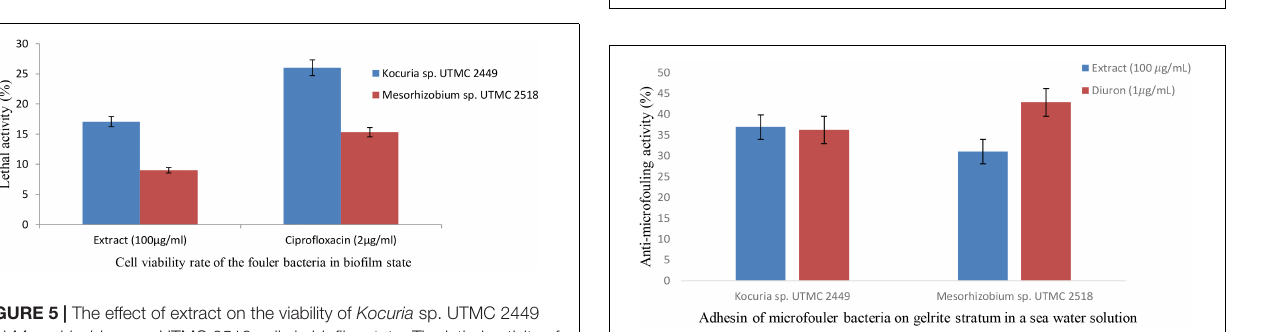
FIGURE 6 | Hemolytic activity of Glycomyces sp. UTMC 2460 crude extract on human red blood cell. Almost no or a low hemolytic effect was detected at low concentrations of the extract (50, 100, and 200 µ g ml − 1 ). Hemolysis activity was evaluated in comparison to FeSO 4 solution (65 mM) as a positive control.